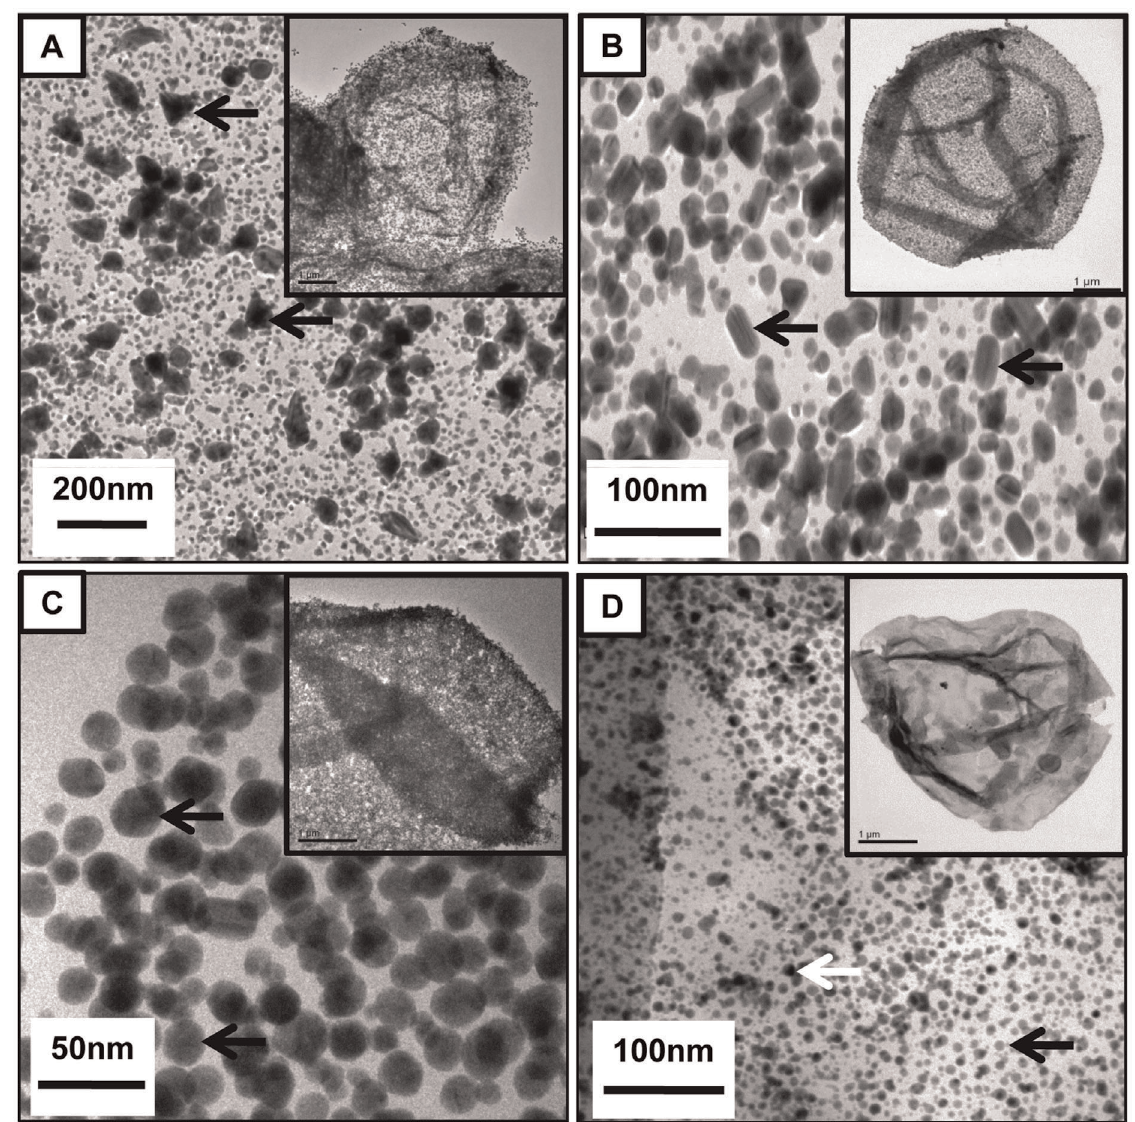
Figure 4. PSS/PAH capsules loaded with different shapes of nanoparticles and co-loaded with two types of nanoparticles. TEM image of PSS/PAH capsules loaded with (a) gold nanoprism, (b) gold nanorods, (c) multifaceted gold nanostructures and (d) Au and LaVO 4 :Eu 3 + (5%) nanoparticles (co-loaded, black and white arrow show LaVO 4 :Eu 3 + (5%) and Au nanoparticles respectively.).